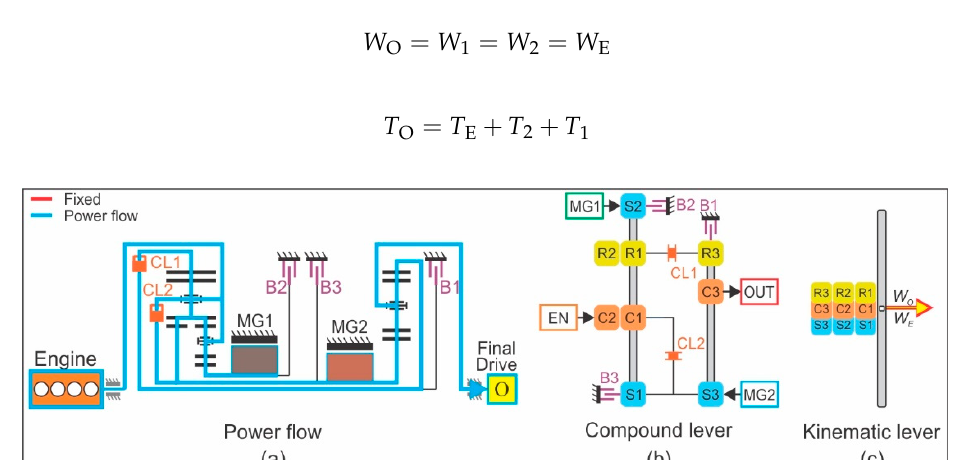
Figure 23. Fourth fixed gear.